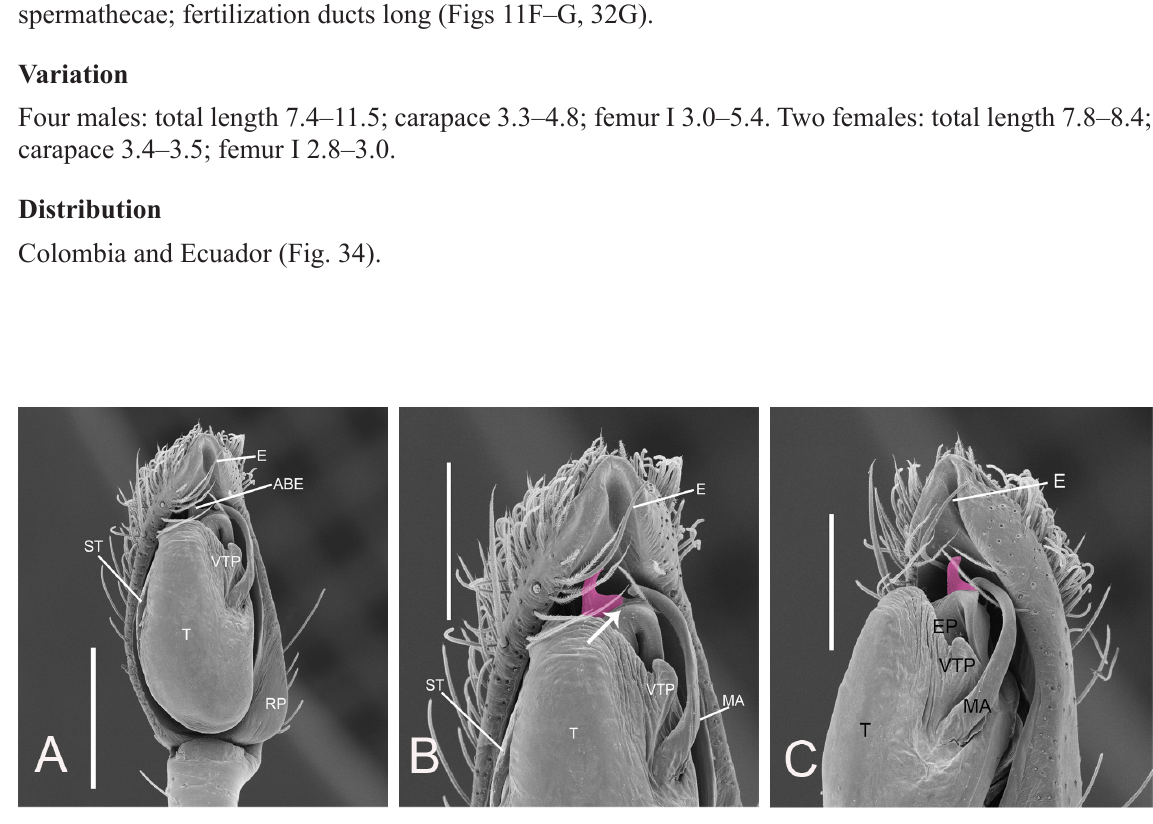
Fig. 12. Tafana straminea (L. Koch, 1866), ♂ (MCZ). A . Left palp, ventral view. B . Left palp, ventral view (arrow indicating the base of the embolus). C . Left palp, retrolateral view. Abbreviations: ABE = apophysis of base of the embolus; E = embolus; EP = embolic process; MA = median apophysis; RP = retrolateral projection; ST = subtegulum; T = tegulum; VTP = ventral tegular process. Scale bars: A, C = 0.5 mm; B = 0.3